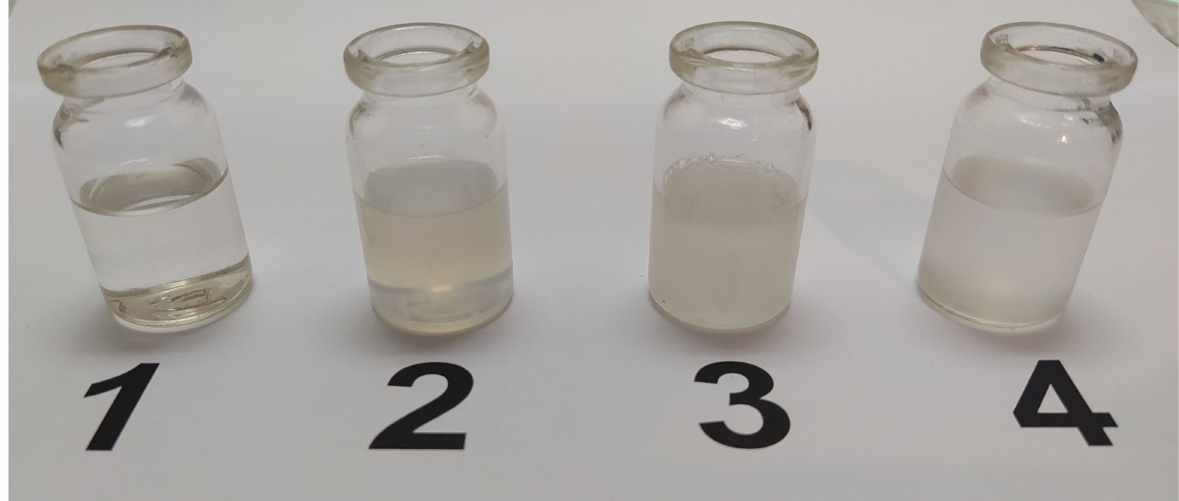
Figure 11. Solutions of copolymer V in butyl acetate (1), chloroform (2), trichloroethylene (3), and toluene